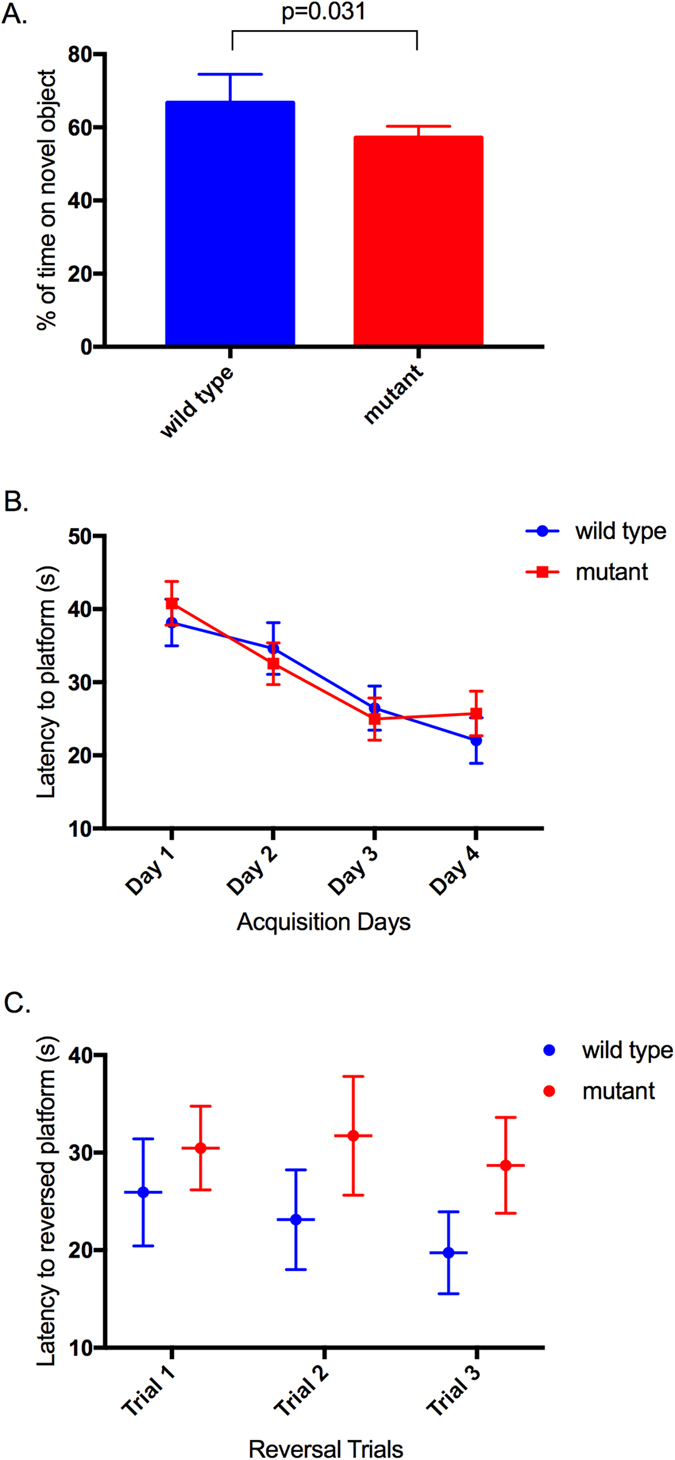
nBmp2NLStm mice exhibit object memory deficits in the novel object recognition task.(A) Six-month-old wild type and mutant mice were tested in the novel object recognition task. Each mouse was allowed to explore the open-field arena and its objects for 10 minutes. 90 minutes later, one of the objects was replaced with a novel object and each mouse was placed in the arena for 10 more minutes. Results are expressed as (time spent interacting with the novel object/total time spent interacting with the novel and familiar objects) × 100 ± SEM and include the results of 7 different trials. (B,C) Six-month-old wild type and mutant mice were tested in the Morris water maze. (B) Acquisition phase: mice were placed in the water maze and were allowed a maximum of 60 seconds to find the submerged escape platform. Each acquisition phase day represents the mean ± SEM of three trials for each mouse in each group (n = 14 for wild type, n = 16 for mutant). (C) Platform reversal phase: on day 5, the position of the escape platform was moved to the opposite quadrant of the tank. Mice were placed in each of the other three quadrants and allowed a maximum of 60 seconds to find the escape platform. Results are reported as mean ± SEM.